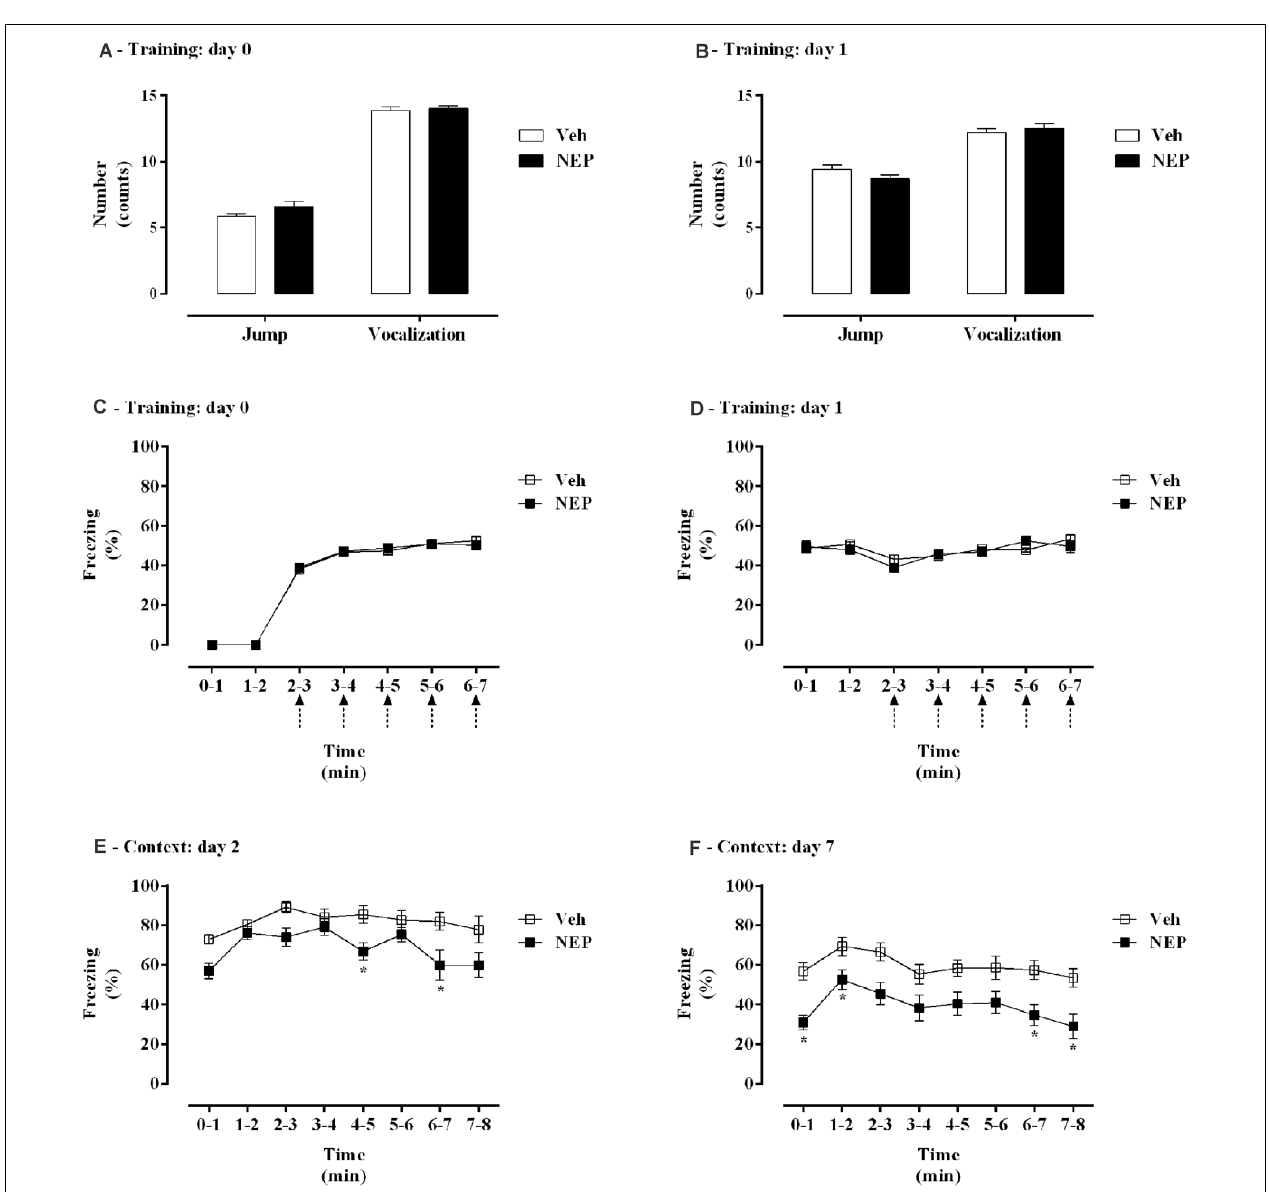
FIGURE 2 | (A,B) Shock responsivity and (C–F) freezing behavior during induction of post-traumatic stress disorder (PTSD) on (A,C) day 0, (B,D) day 1, (E) day 2, and (F) day 7. Values are means ± SEM of 13–15 mice per group from both experimental protocols. Veh, mice in the PTSD-group and treated with vehicle; NEP, mice in the PTSD-group and treated with nepicastat; ↑ = 3 footshocks delivered with a duration of 10 s and a 10 s interval; *, significantly different from correspondent values in mice in the PTSD-group and treated with vehicle ( p < 0.05).